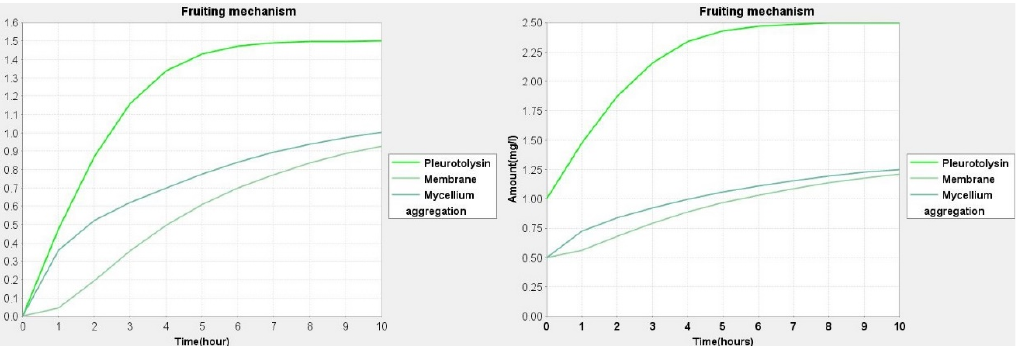
Figure 3. Simulation curve for Pleurotolysin protein and membrane receptor with respect to mycelium aggregation, the amount of Pleurotolysin was set at 0.0 and 1.0, respectively, while and membrane receptor and mycelium aggregation were set to 0 and 0.5.